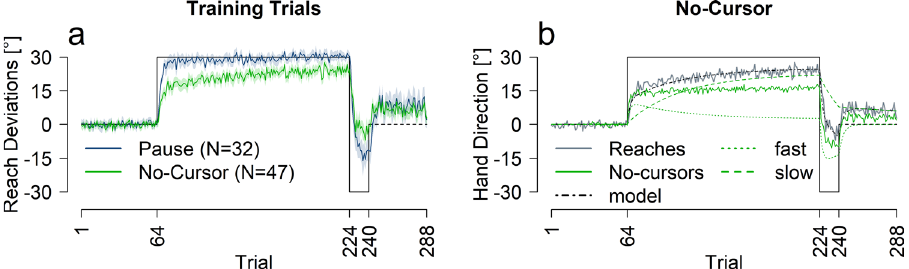
Figure 1. Performance across measures for pause and no-cursor groups. ( a ) Reach training performance averaged across all participants for the two groups. ( b ) Two-rate model fit (black and green dashed lines), and no-cursor test trials in solid green. For reference, reach performance for the no-cursor group is plotted again in grey. All solid lines are an average of all participants in that group, shaded regions are 95% confidence intervals. Trials included in analysis are as follows: R1 = trials 65–68; R1_Late = trials 221–224; R2 = trials 237–240; EC = 273–288.